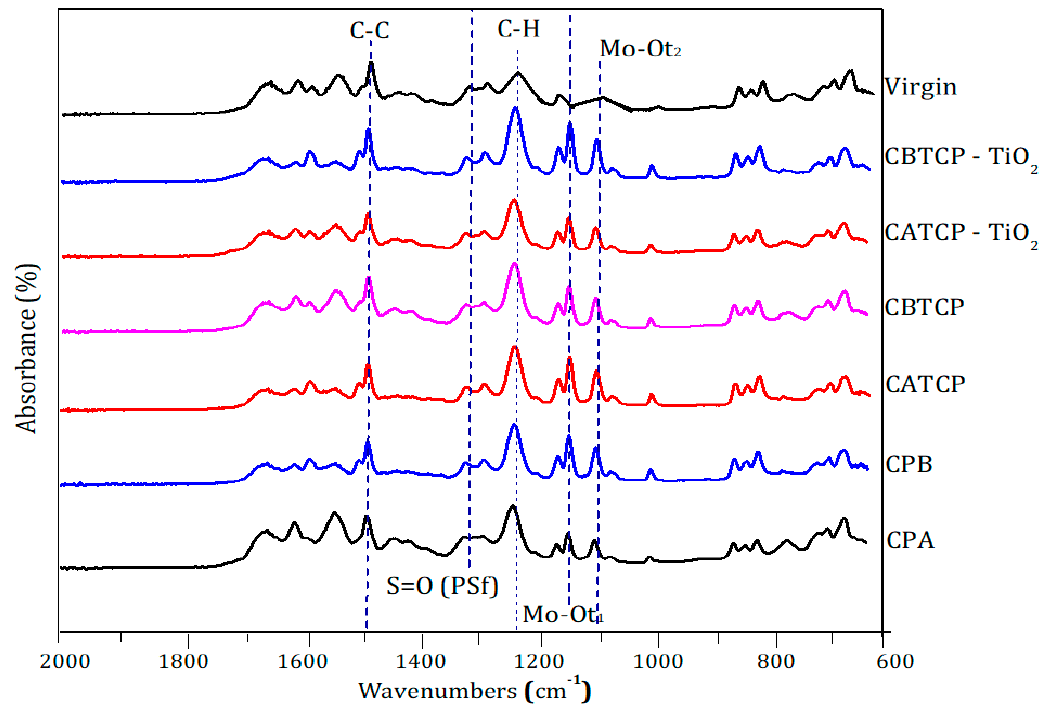
Figure 8. ATR-FTIR of the TFC and TFN membranes.